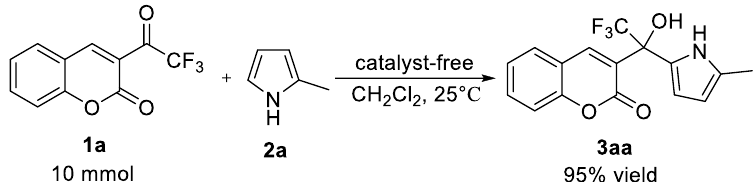
Scheme 1. Scaled-up experiment of the one-pot